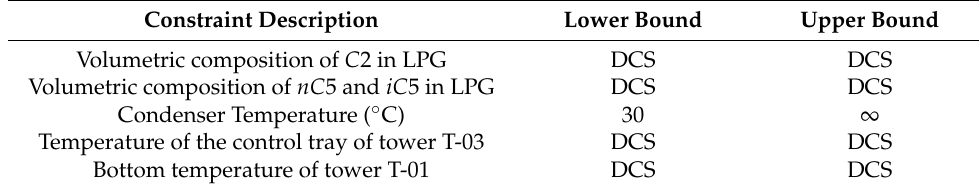
Table 5. Additional constraints of the Optimization